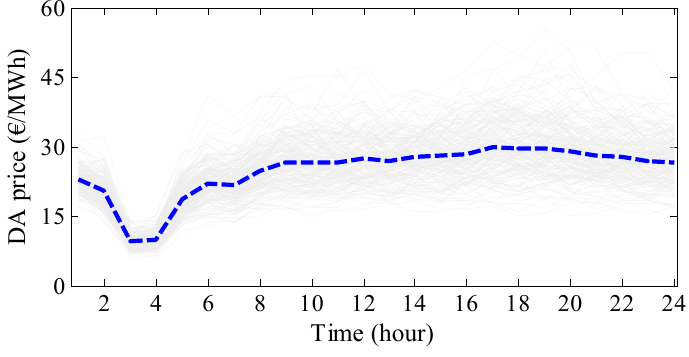
Figure 3. Scenarios and mean of day-ahead price. Appl. Sci. 2017 , 7 , 1100